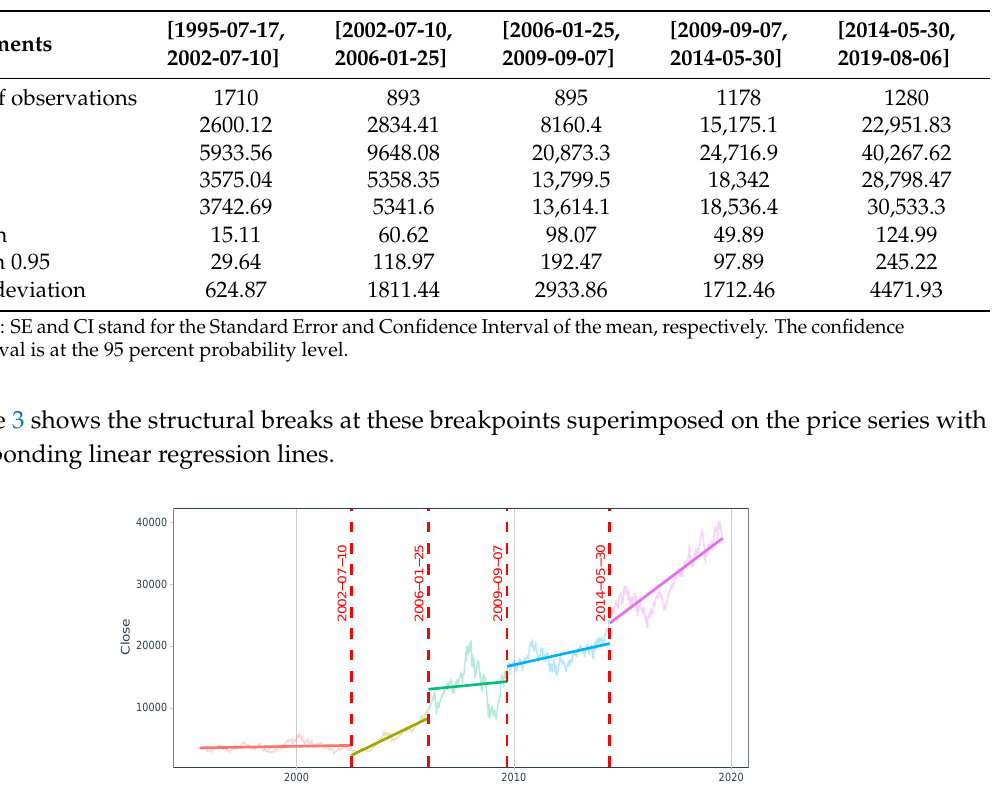
Table 2. Break-wise summary statistics of the data.